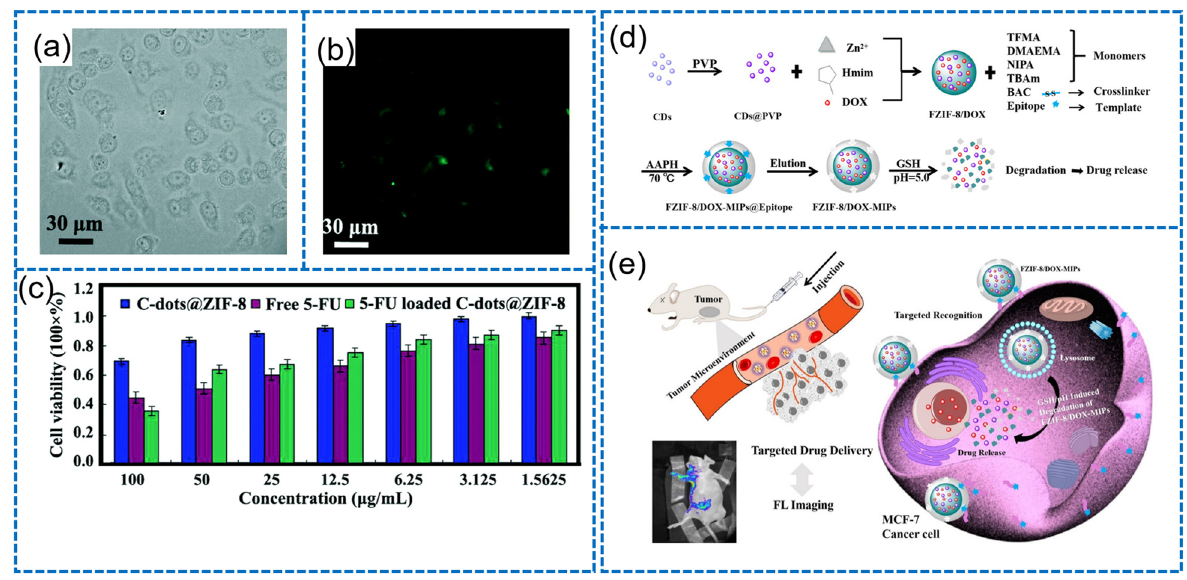
Figure 7: ( a ) The picture of di ff erential interference contrast. ( b ) Adopted 5 - FU - encumbered C - dots@ZIF - 8 with spot - like green fl uorescence. ( c ) Cytotoxicity toward Hela cells in vitro [ 129 ] . ( d ) FZIF - 8/DOX - MIP production and GSH/pH route of twofold stimulation and decay. ( e ) Graphical representation of tailored imaging and GSH/pH - receptive drug transport of FZIF - 8/DOX - MIPs [ 130 ]